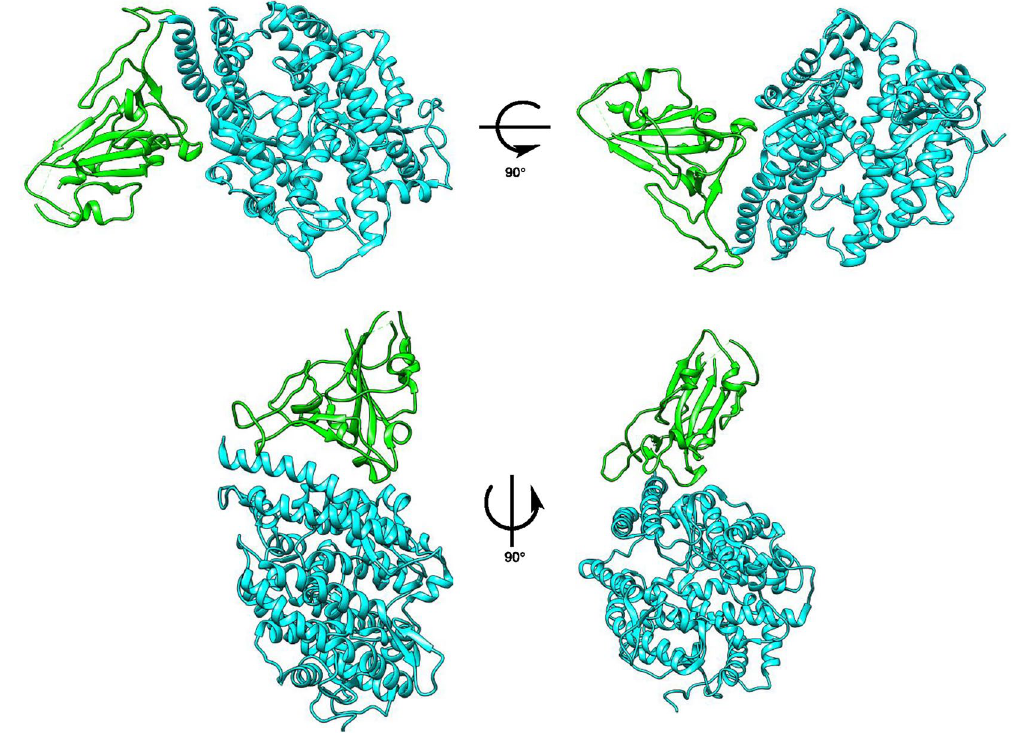
Figure 2. ACE2 and SARS-CoV-2 spike glycoprotein (6M17) (Cyan: ACE2; Green: RBD).